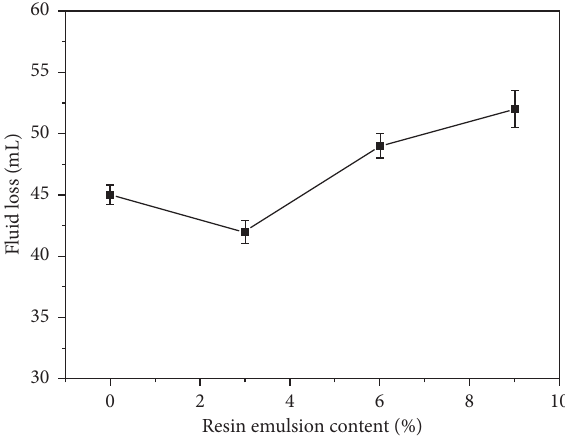
Figure 2: Water loss of resin emulsion cement